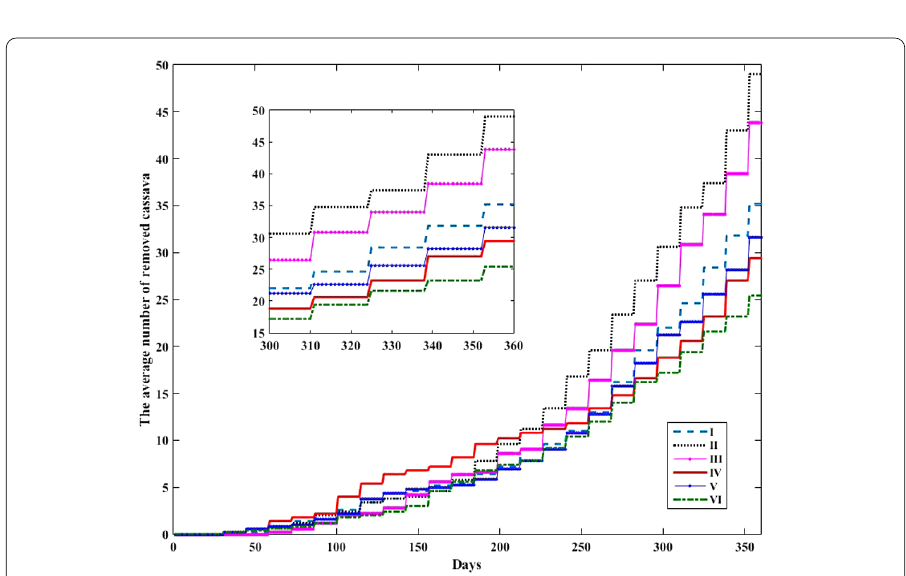
Figure 5 The average number of removed cassava